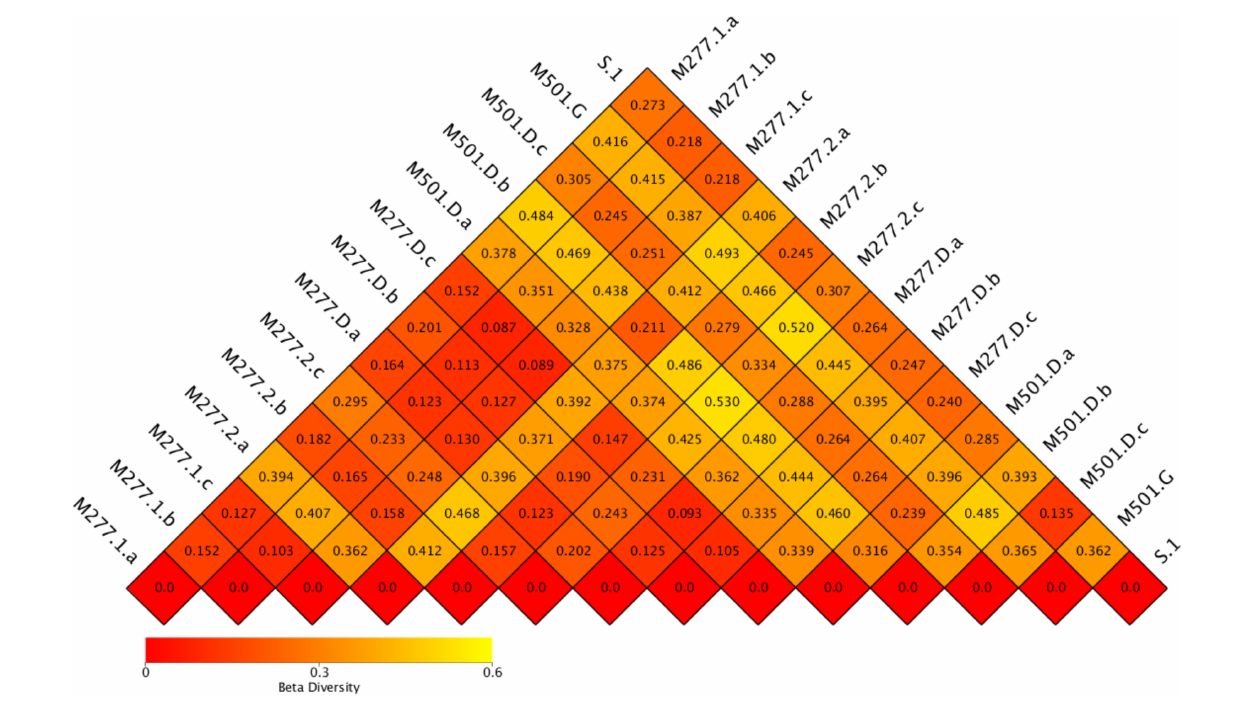
FIGURE 7 | Beta diversity index heatmap of soil samples in tombs.